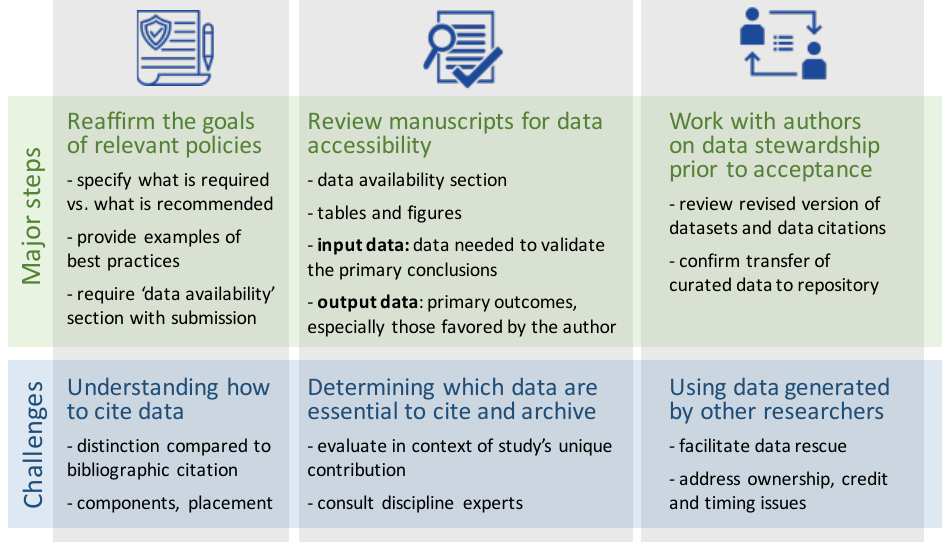
Figure 1. Summary of editor and reviewer roles in implementing open data as part of publication.